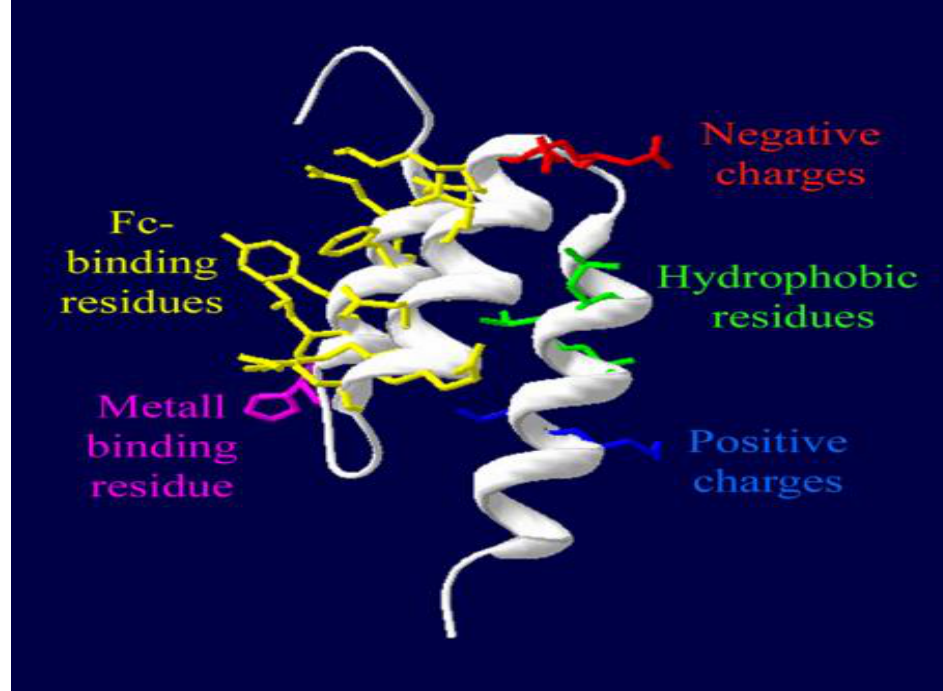
Figure 8. An example of properties that are used to separate proteins from one another [38].